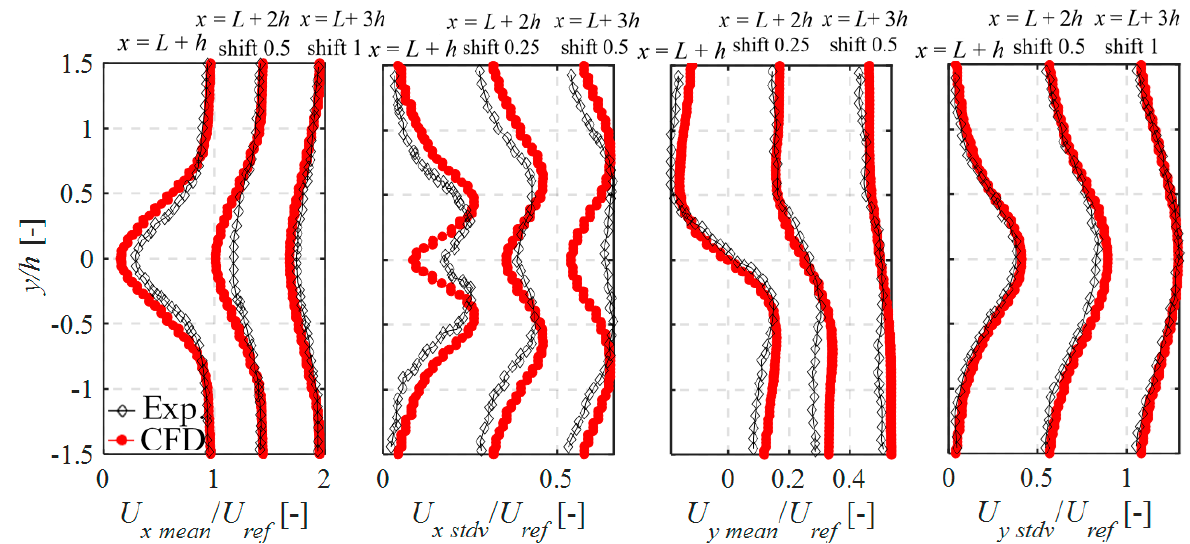
Figure 6. Comparison of experimental and simulated results.